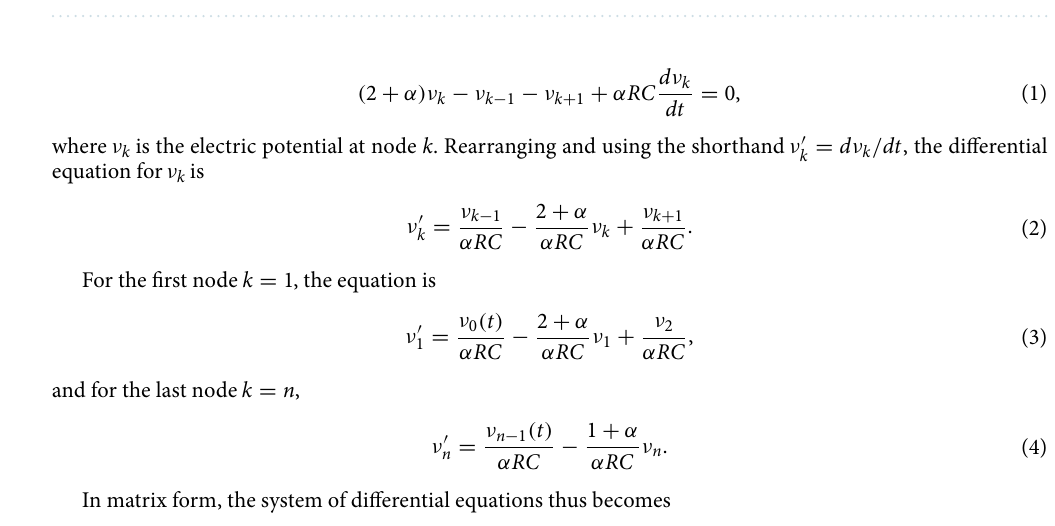
Figure 7. Response of node potentials for parameters α = 1, R = 1 � , C = 10 − 3 F , and | ν 0 | = 50 V . Tiles attach every t = 0.003 s, causing the node potentials to undergo transients before returning toward steady-state values. With a threshold of τ = 3 V , no further attachments occur past node k = 4